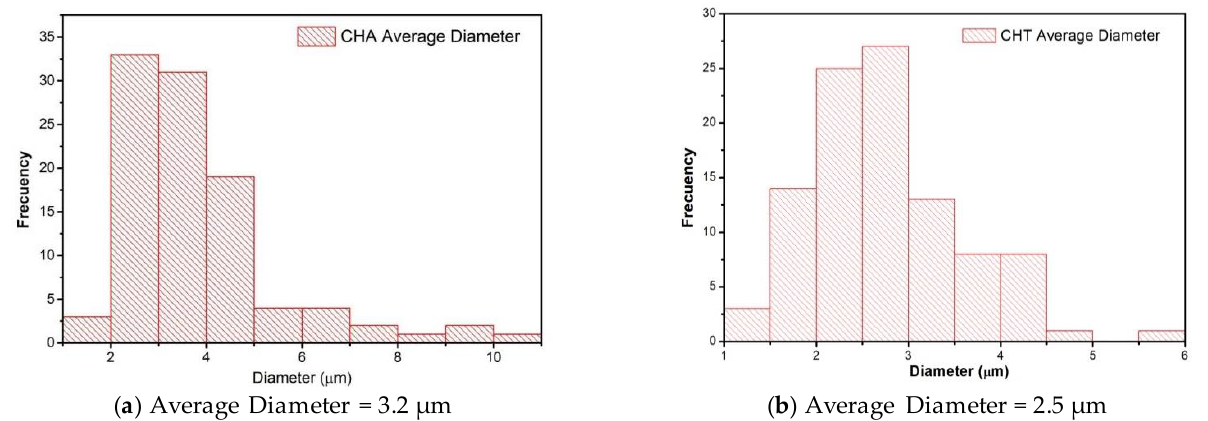
Figure 3. Particle size distribution: ( a ) CHT, and ( b ) CHA film (Programa ImageJ ® ). Frequency: number of particles of the same size that are repeated.